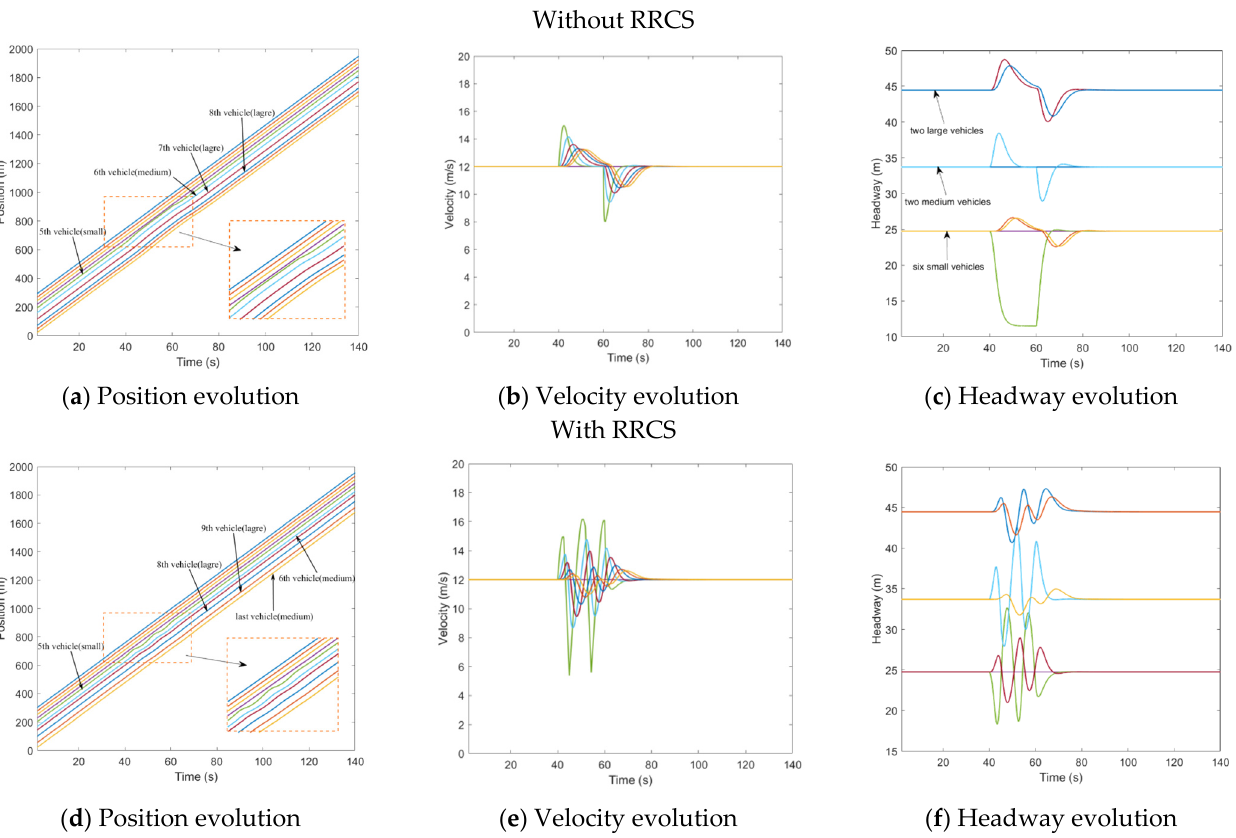
Figure 3. Mixed traffic flow evolution diagrams under the overestimated velocity with/without RRCS.